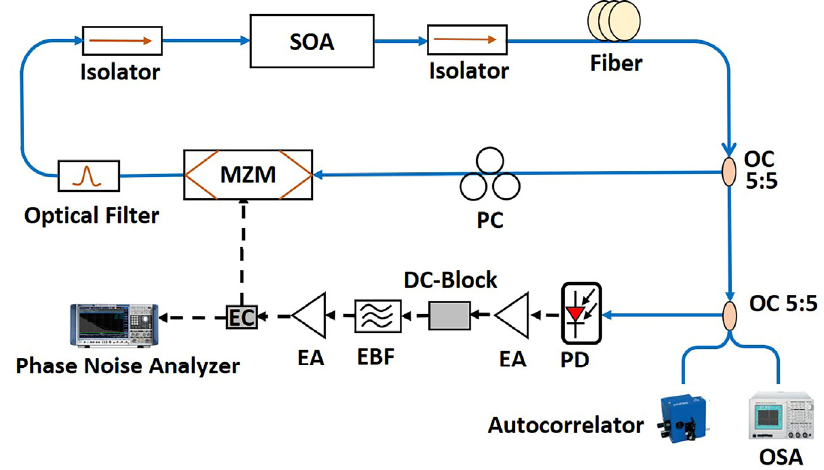
Figure 1. Schematic of the regenerative mode-locked laser. SOA: semiconductor optical amplifier; OC: optical coupler; PC: polarization controller; MZM: Mach–Zehnder intensity modulator; PD: photodetector; EA: electrical amplifier; EBF: electrical bandpass filter; EC: electrical coupler; OSA: optical spectrum analyzer.